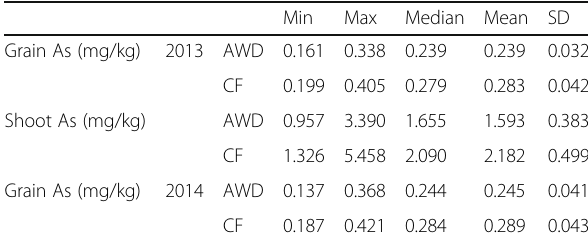
Table 1 Descriptive statistics for the grain and shoot arsenic concentration measured in 2013 and 2014 for the accessions grown under AWD and CF Min Max Median Mean SD Grain As (mg/kg) 2013 AWD 0.161 0.338